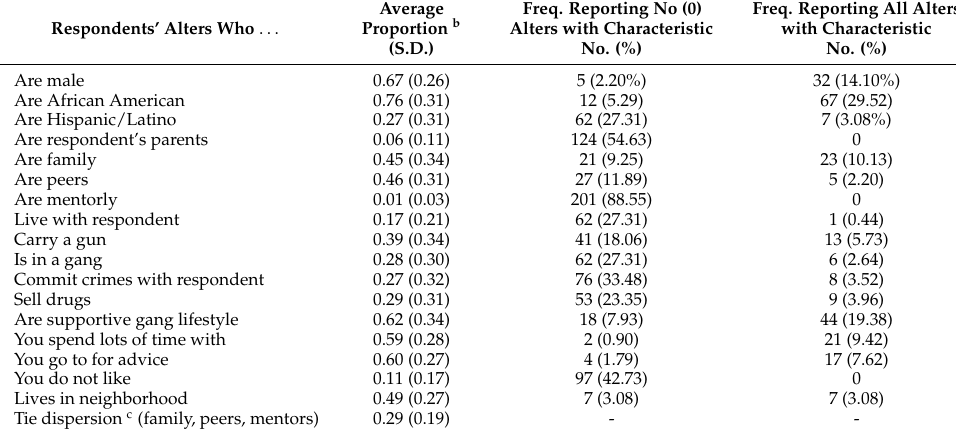
Table 3. Compositional Characteristics and Network Exposure at Wave 1, n = 227 a . Respondents’ Alters Who